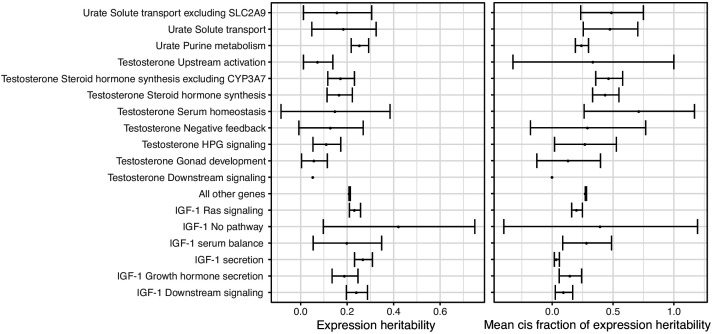
Distributions of (left) total SNP-based heritability of gene expression, or (right) fraction of expression SNP-based heritability driven by cis-effects (Ouwens et al., 2020) for genes in the indicated core pathways, or for all other MsigDB genes not in a core pathway.Points indicate means, error bars indicate two standard deviations.